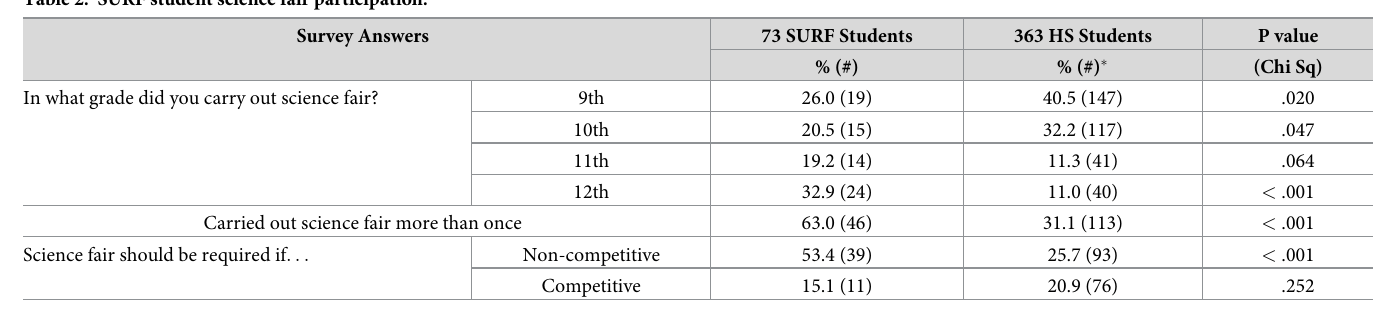
Table 2. SURF student science fair participation.